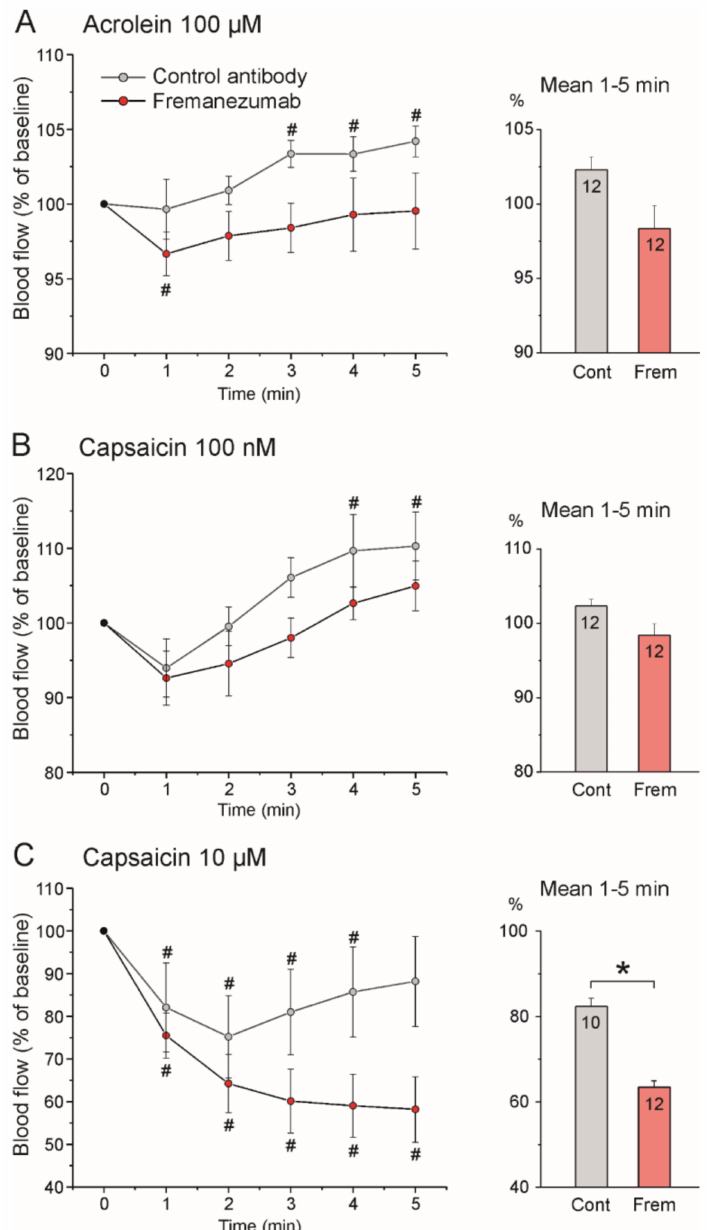
Figure 6. Stimulated blood flow of the dura mater (means ± SEM) of rats of both sexes 13–20 days after injection of either control antibody (grey) or fremanezumab (red) before stimulation with acrolein ( A ) and capsaicin at two doses ( B , C ). Blood flow was normalized to the baseline flow prior to stimulation; # significant difference to baseline; * significant difference between control antibody and fremanezumab experiments; numbers within columns denote counts of